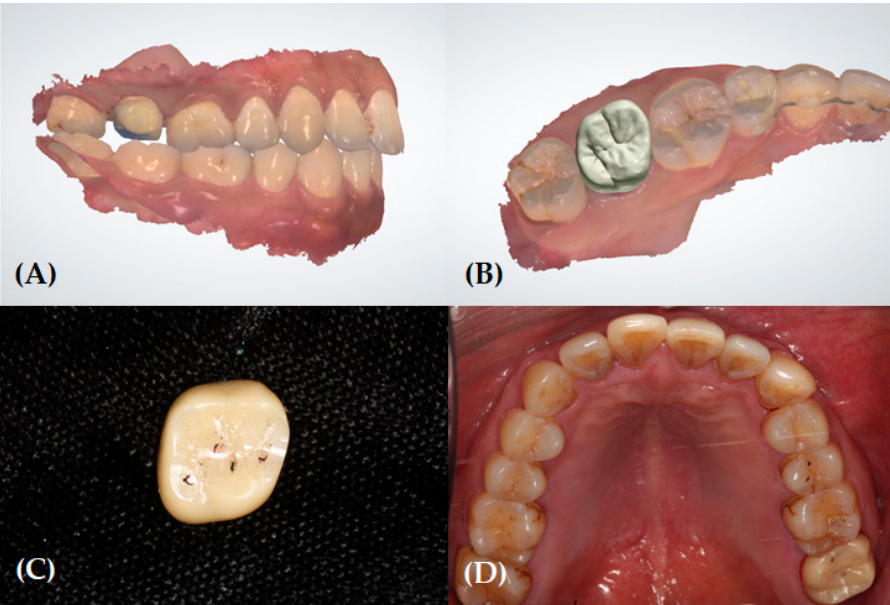
Figure 2. Clinical procedure for the reference data (PRE and POST). ( A ) Quadrant intraoral scan data of a prepared tooth obtained using the IOS (Trios 3). ( B ) Design of the occlusal morphology of a single posterior crown. The crown was designed based on a static occlusal relationship using CAD software (3shape Dental System). The finished CAD design was considered to be the reference CAD data (PRE). ( C ) Occlusal surface of a zirconia crown for which a clinical occlusal adjustment was completed under static and dynamic occlusion. ( D ) Intraoral photo of a single crown restoration after the adjustment. The quadrant intraoral scan data of the treated area was considered to be reference data